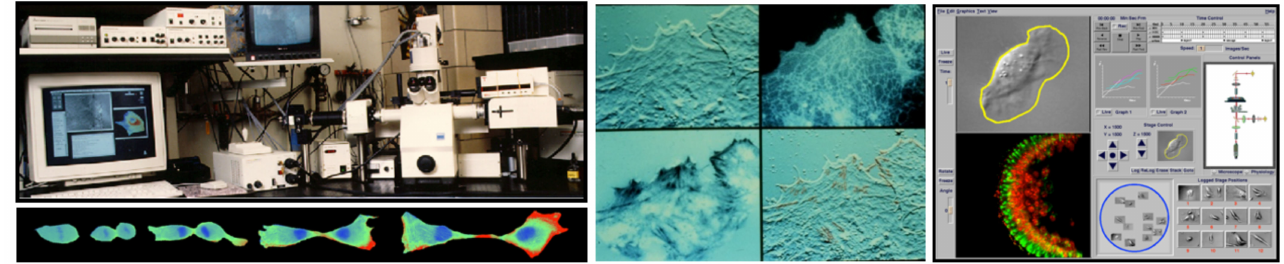
Figure 5. Multimode optical microscopy. ( Left ): First multimode microscopy workstation, with 4 camera ports, and custom image acquisition and processing software written from scratch for robotic-level automation of multimode time lapses. ( Middle ): Typical 3T3 cells imaging dataset, with (clockwise from lower left) reflection interference dynamically showing adhesion points of live cells, differential interference contrast for fine details of leading edges, fluorescence of selected intracellular component (endoplasmic reticulum) and an overlay of the first two panels. ( Right ): Intuitive graphic user interface for setting up automated acquisition in four dimensions and simultaneous monitoring of up to 24 selected locations by stage automation in 3D. After completion, the workstation ran 24/7 for years.